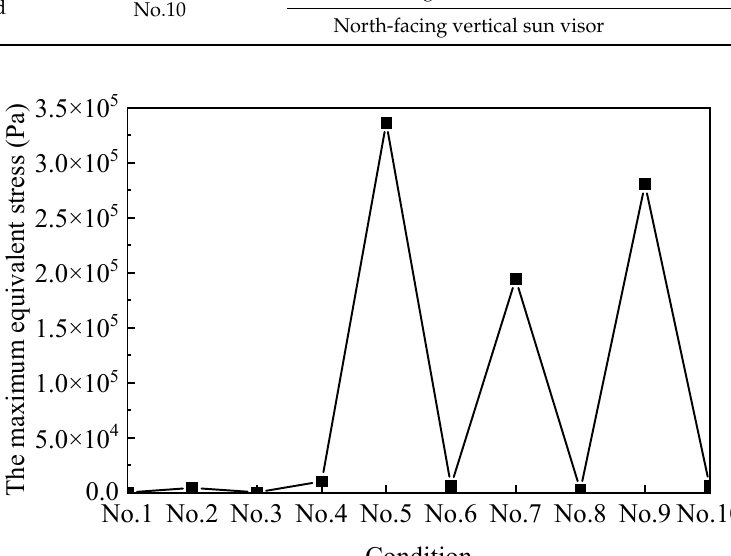
Figure 14. Maximum equivalent stress under 10 working conditions of south-facing horizontal sun visors.